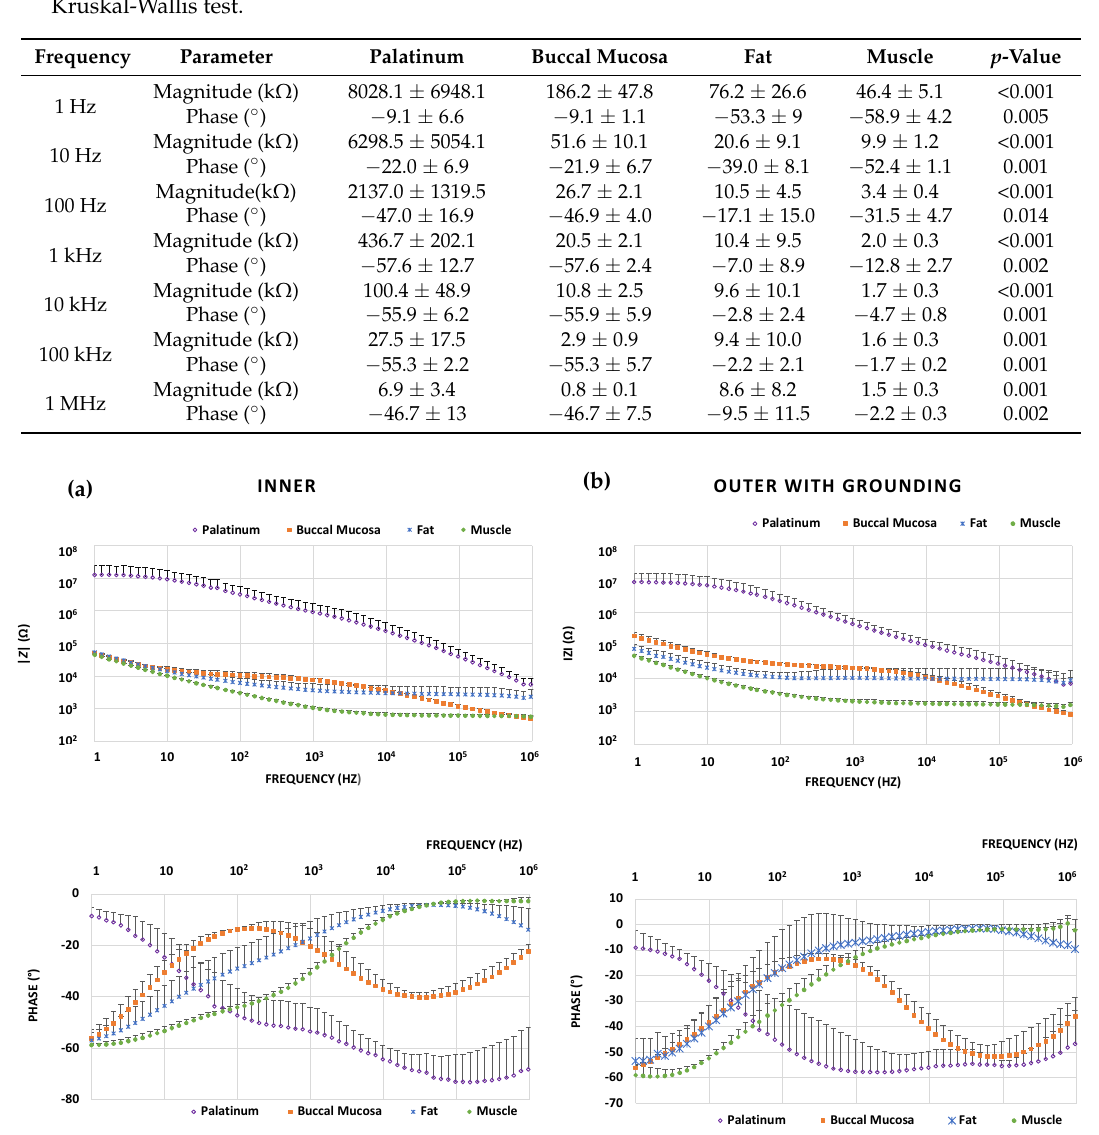
Figure 6. Bode plots of mean BIS spectra for different ex vivo pork oral tissue samples using ( a ) the inner configuration and ( b ) the outer with grounding configuration. Error bars represent the standard deviation of the mean value in one direction.